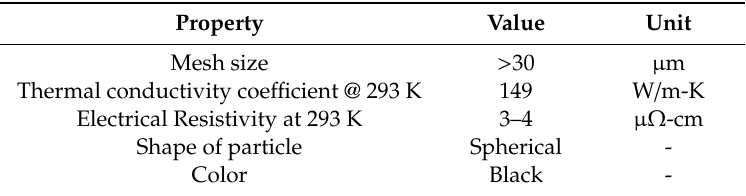
Table 3. Properties of Si Powder